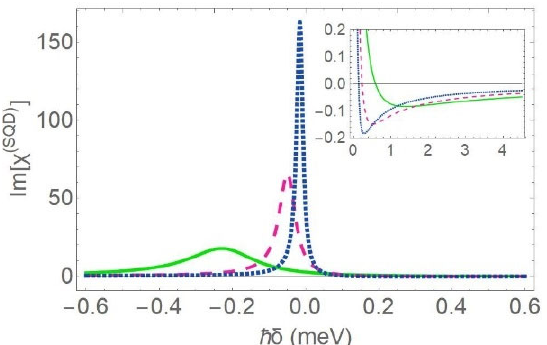
Figure 5. The linear absorption spectra for the SQD, for different values of the center-to-center distance (green solid curve: R = 11.5 nm, pink dashed curve: 13.5 nm, blue dotted curve: 15.5 nm and turquoise dashed-dotted curve: 100 nm). The dielectric constant of the core ε c is set equal to 7.5 and the rest physical parameters take the same values as in Figure 3.